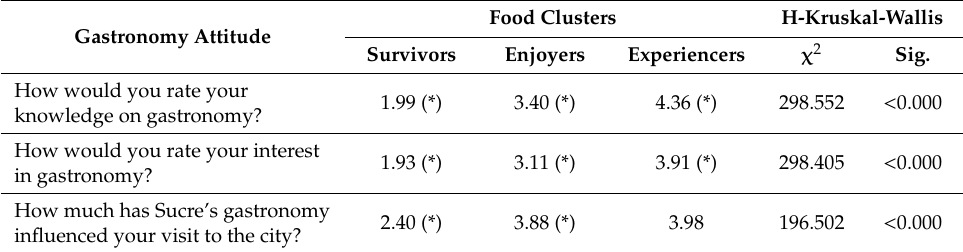
Table 1. Characterisation clusters from gastronomy attitude.